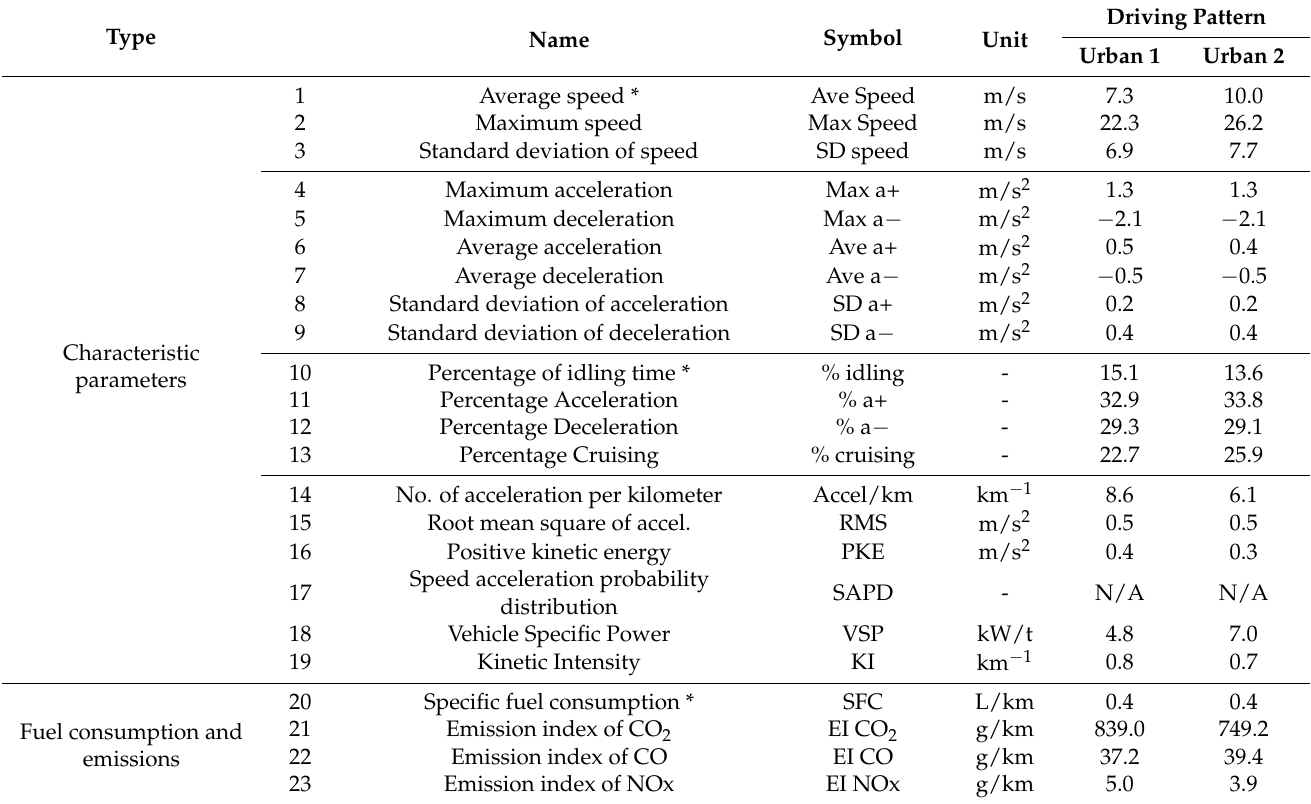
Table 1. Characteristics parameters (CP i ), emissions, and fuel consumption used to describe driving patterns and driving cycles in this